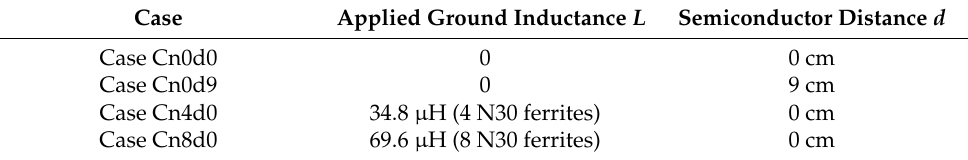
Table 3. Coaxial injection test